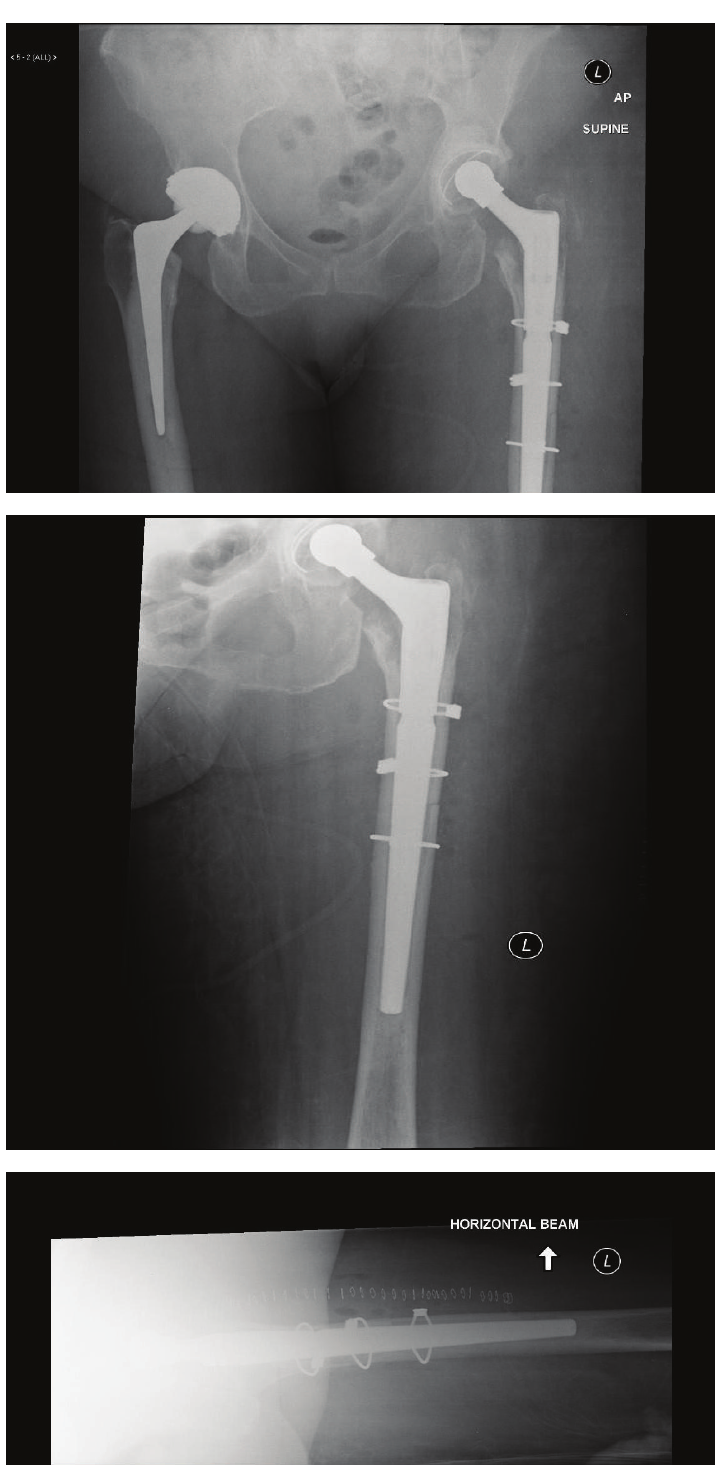
Figure 3: Postoperative AP and lateral films with revision “restoration” Stryker